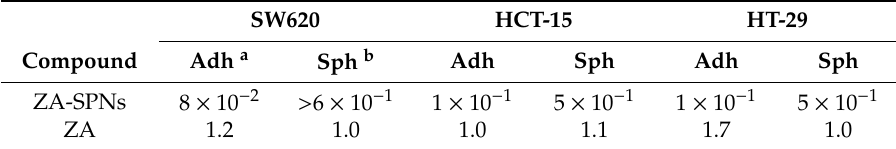
Table 2. In vitro e ff ect (EC 50 ) of ZA-SPNs and soluble ZA on the V δ 2-mediated cytotoxicity of CRC cells and spheroids. SW620 HCT-15 HT-29 Compound Adh a Sph b Adh Sph Adh Sph ZA-SPNs 8 × 10 − 2 > 6 × 10 − 1 1 × 10 − 1 5 × 10 − 1 1 × 10 − 1 5 × 10 − 1 ZA 1.2 1.0 1.0 1.1 1.7